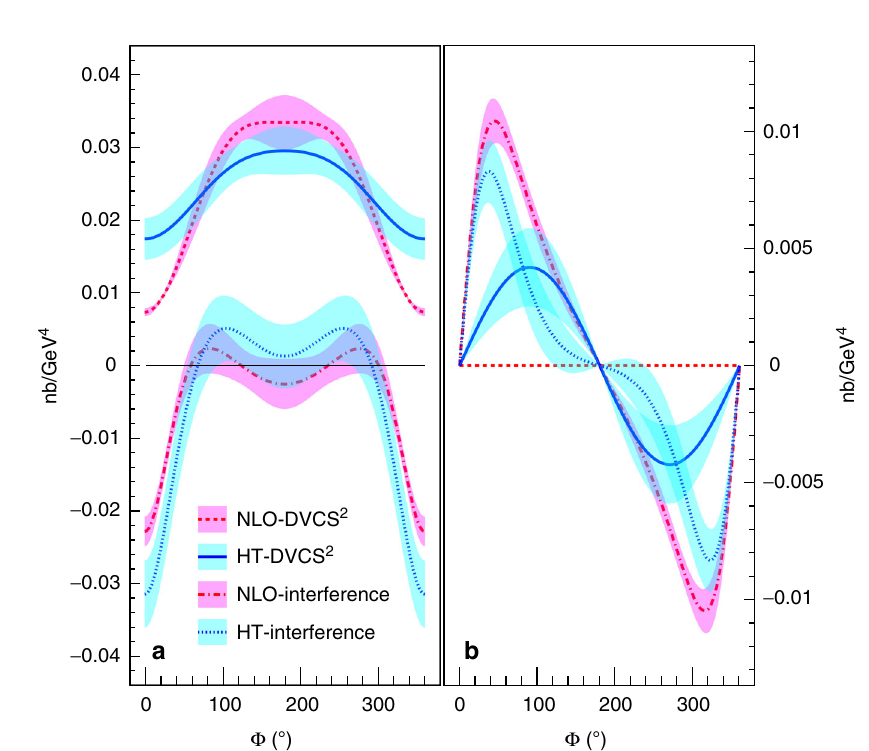
Fig. 5 A generalized Rosenbluth separation. DVCS 2 and DVCS-BH interference contributions are shown at Q 2 = 1.75 GeV 2 , x B = 0.36, t = − 0.30 GeV 2 , and E beam = 5.55 GeV for the helicity-independent ( a ) and helicity-dependent ( b ) cross sections. Solid and dotted lines represent these contributions for the twist-3 (HT) scenario; dashed and dashed-dotted lines correspond to the NLO scenario. Bands show s.d. statistical uncertainties. A DVCS 2 contribution appears in the helicity-dependent cross section only if there is a contribution from the longitudinal polarization of the virtual photon (HT